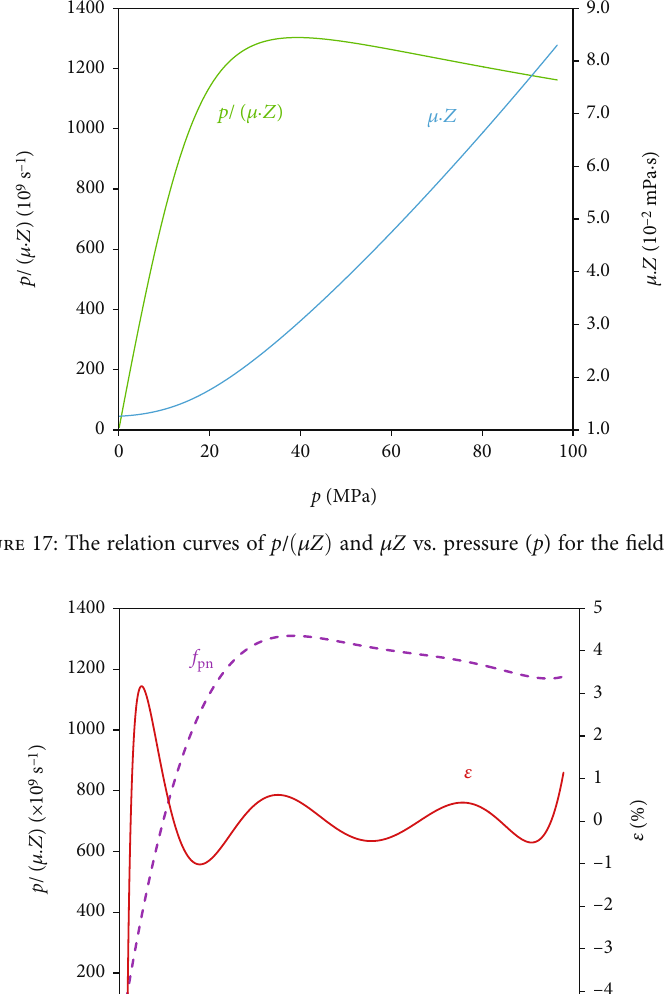
for the fi eld pn